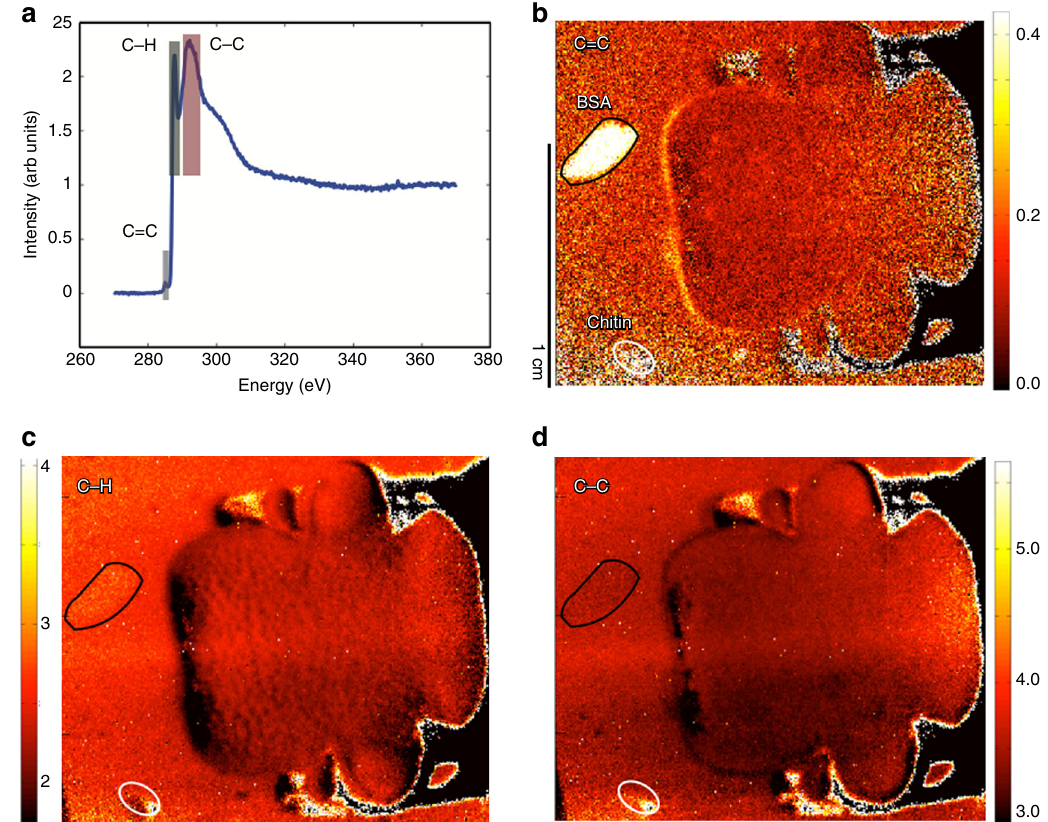
Fig. 4 NEXAFS images of the scarab head at different resonance energies. a NEXAFS carbon spectra averaged across the entire sample. Energy regions for the extracted images related to speci fi c regions are indicated. b NEXAFS image related to photoemission near 285 eV. This spectral range corresponds to aromatic C = C bonds. c Image related to the C – H region near 286 – 290 eV. d Image representative for C – C bonds in the region from 290 to 297 eV. While the C – C bonds are evenly distributed across the scarab head, C – H and aromatic species shows spatial variation. All spectra and images are pre- and post- edge normalized and therefore representative of the number of the respective bonds with respect to the total amount of carbon. Areas marked in black or white indicate the position of albumin (top) and chitin (bottom) reference materials. All images and spectra are pre- and post-edge